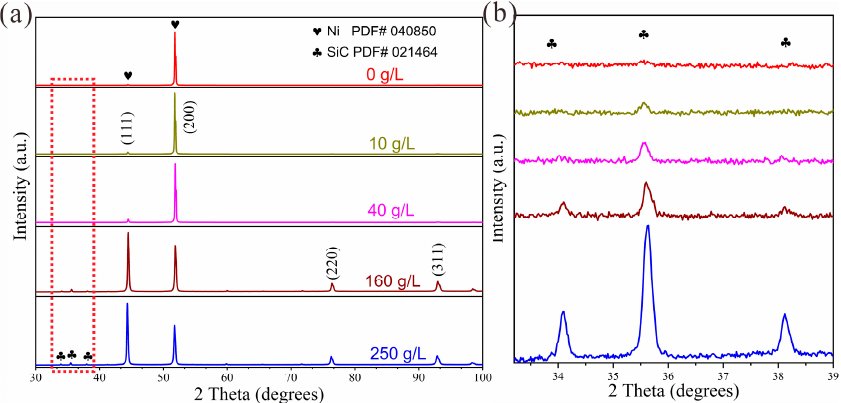
Figure 1. ( a ) XRD patterns of Ni-SiC coatings electrodeposited from Watts solution containing var- ious concentrations of SiC particles, and ( b ) the magnified images of area marked by the red dotted